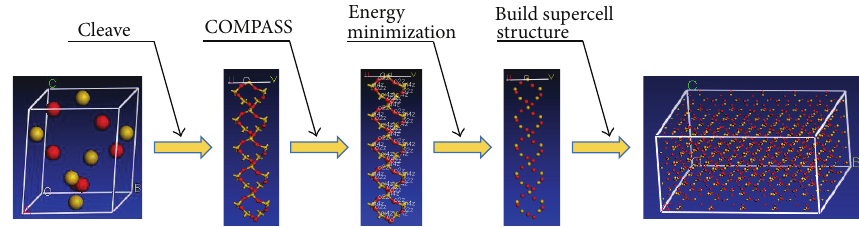
Figure 6: The process of building supercell structure.